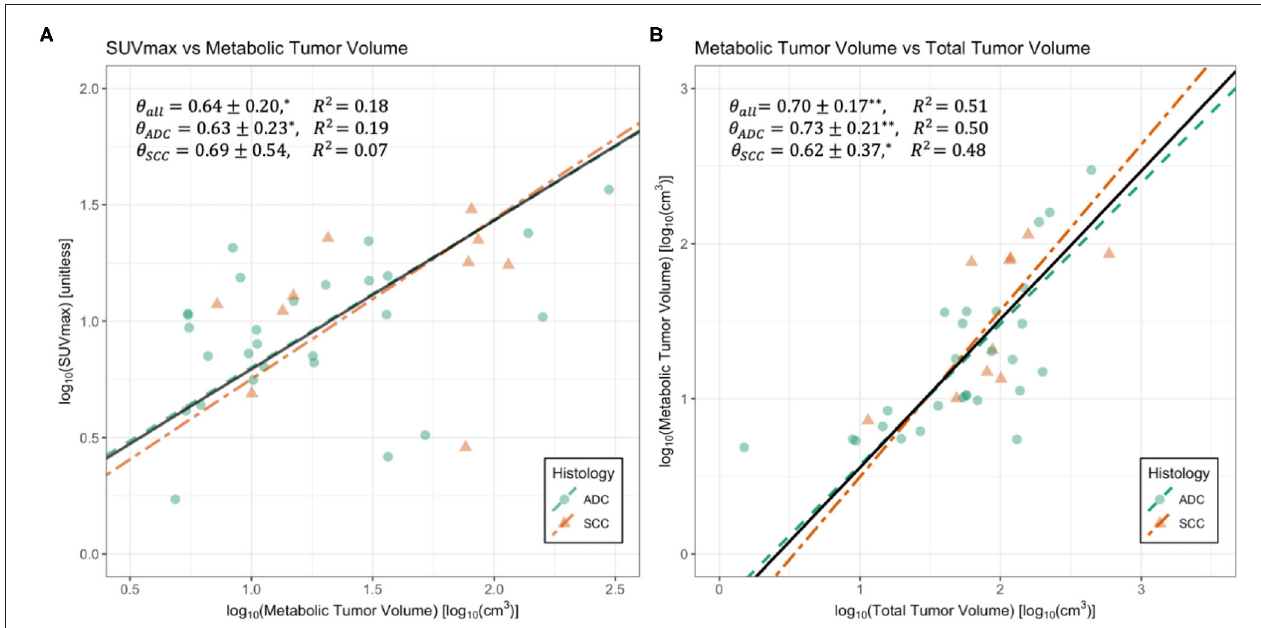
FIGURE 2 | Regressions for maximum standard uptake value ( SUV max ) vs. metabolic tumor volume ( MTV ) (A) and MTV vs. gross tumor volume ( GTV ) (B) . Data is divided by the histological classifications of adenocarcinoma (ADC) and squamous cell carcinoma (SCC). Black solid lines represent regressions on whole datasets. Summaries of regressions are presented in Table 1 . *Indicates p < 0.05, and ** indicates p < 0.005. Standard major axis regression shows that both methods result in significant and consistent measurements of metabolic scaling exponents.